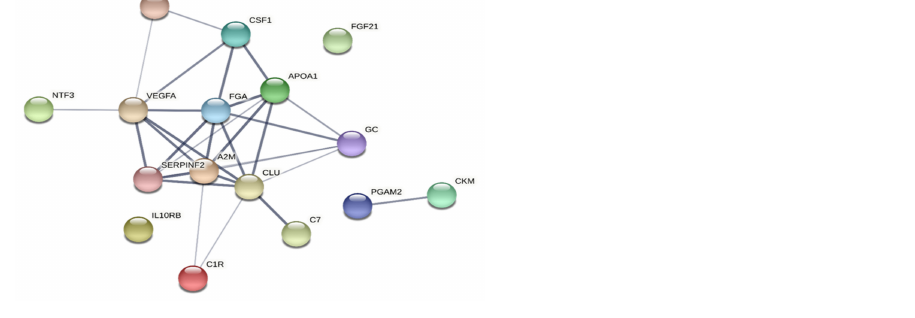
Figure 5. Network analyses of important proteins for HPT in CWP. The network had the following characteristics: number of nodes: 16; number of edges: 29; average node degree: 3.62; avg. local clustering coefficient: 0.71; expected number of edges: 3; PPI enrichment p -value: < 1.0 × 10 − 16 . Note that Ig light chain is not included in STRING. SERPINF2 = alpha-2-antiplasmin; A2M = alpha-2- macroglobulin; APOA1 = apolipoprotein A-I; CKM = creatine kinase M-type; PGAM2 = phosphoglyc- erate mutase 2; CLU = clusterin; C1R = complement C1r subcomponent; C7 = complement component C7; CSF1 = colony stimulating factor 1; FGF21 = fibroblast growth factor 21; FGA = fibrinogen alpha chain; FLT3LG = Fms-related tyrosine kinase 3 ligand; IL10RB = interleukin-10 receptor subunit beta; NTF3 = neurotrophin-3; TNFRSF9 = tumour necrosis factor receptor superfamily member 9; VEGFA = vascular endothelial growth factor A; GC = vitamin D-binding protein; CWP = chronic widespread pain group; HPT = heat pain